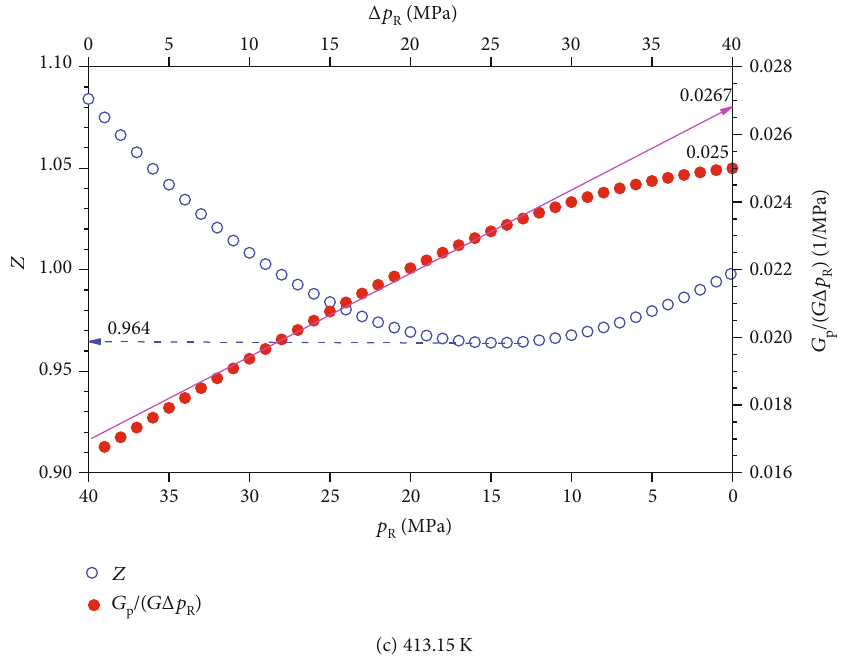
Figure 2: E ff ect of temperature on gas production of cumulative pressure drop. Table 2: Producing history of Anderson “ L ” gas reservoir (Duggan,